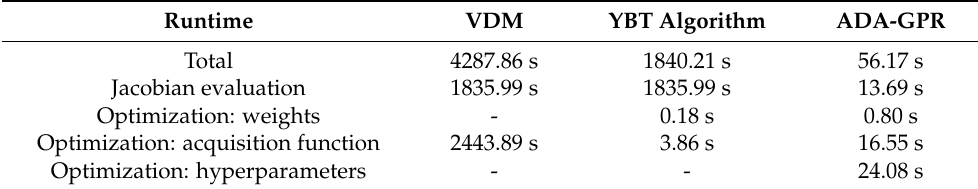
Table 10. Detailed breakdown of the runtime of all algorithms for the flash with a methanol–acetone input feed.